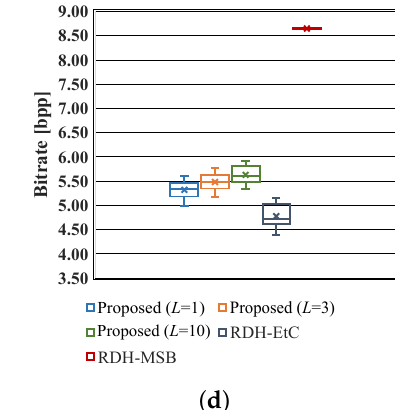
Figure 18. JPEG 2000 compression performance of proposed, RDH-EtC [30] and RDH-MSB [29] methods. ( a ) Kodim4; ( b ) peppar; ( c ) ihc5 (1/16); ( d ) ihc5 (original